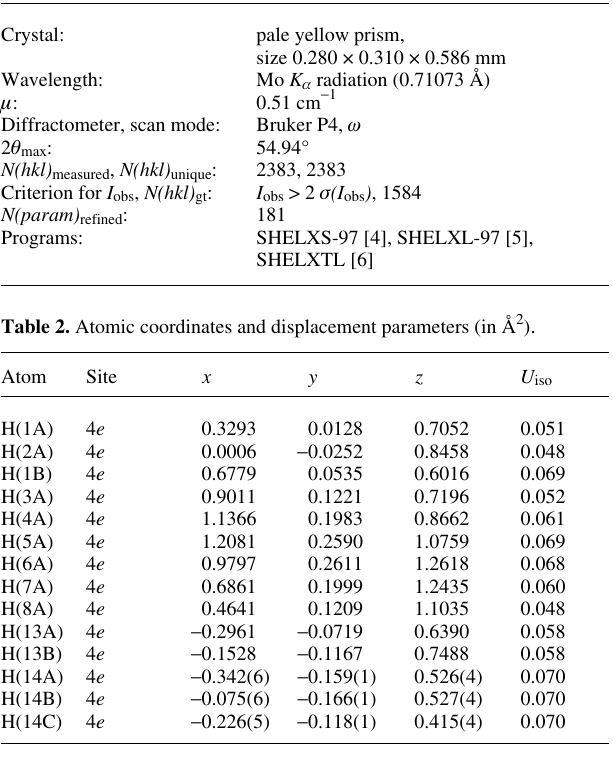
Table 1. Data collection and handling.